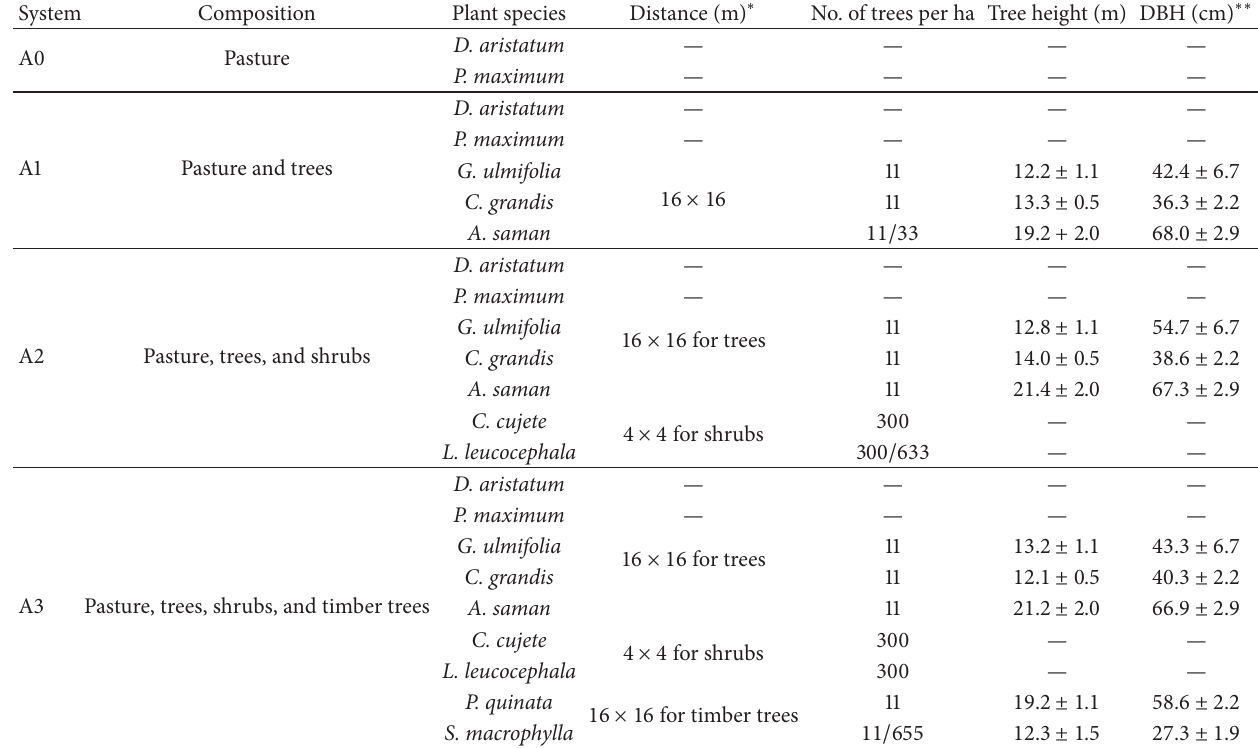
Table 1: Multistrata silvopastoral systems evaluated in the Sinu River Valley,